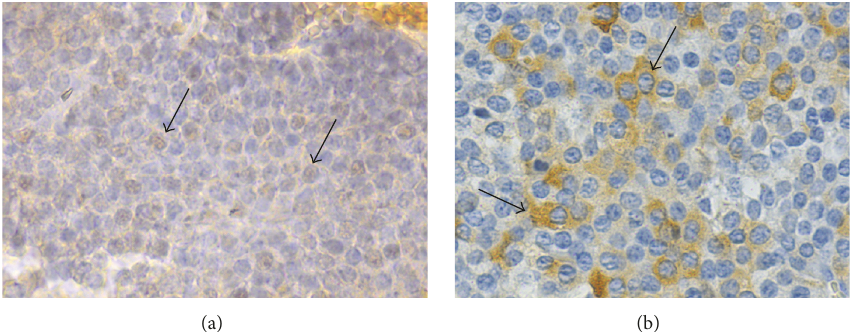
Figure4:MicrographyofimmunohistochemistrystainingwithStreptavidina-Biotinetechniquerevealedwithdiaminobenzidine.(a)Nuclear expression of SF-1 in the first surgery ((a), arrows). (b) Intense positivity for the FSH hormone in the second surgery ((b), arrows) ( ×